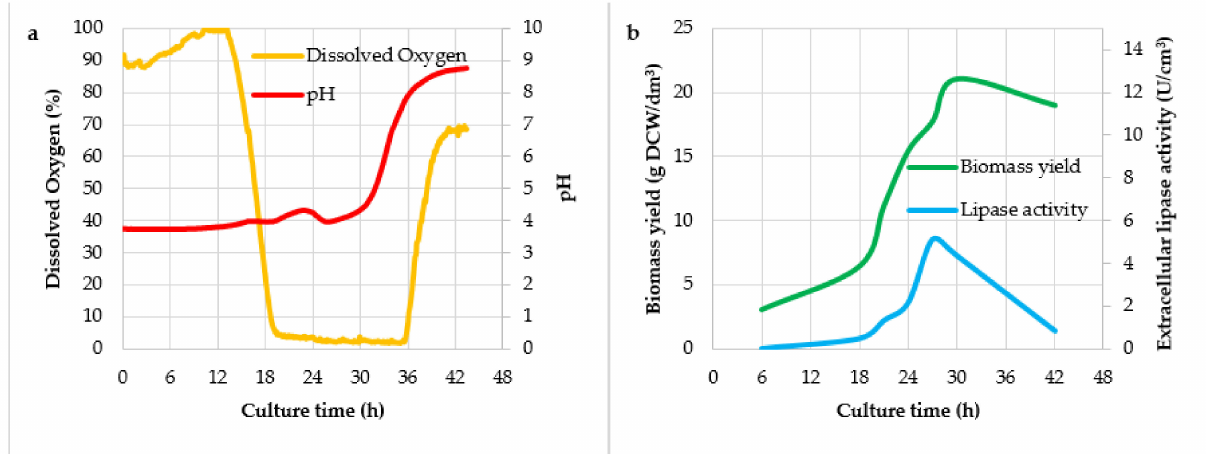
Figure 3. Kinetics of dissolved oxygen and pH ( a ) and biomass yield and extracellular lipase activity ( b ) of the yeast strain Y. lipolytica KKP 379 in the culture with an agitation speed of 400 rpm and air flow of 2 dm 3 /(dm 3 × min).